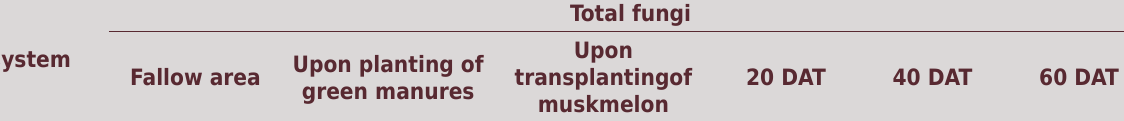
Table 5. Number of colony forming units (CFUs) of fungi in the no-tillage and in the conventional tillage systems in different management systems and soil sampling times